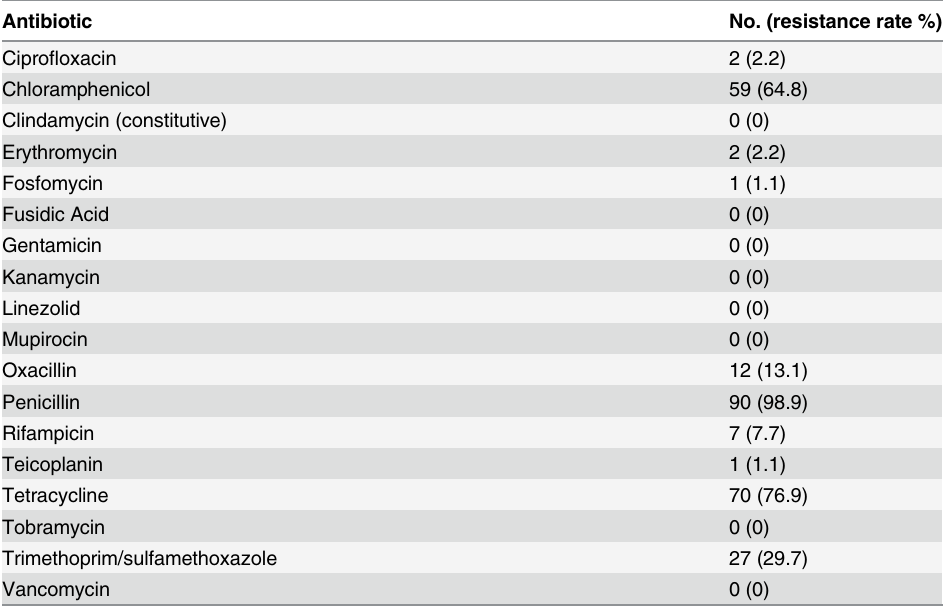
Table 2. Antibiotic resistances of the 91 S. aureus study isolates.